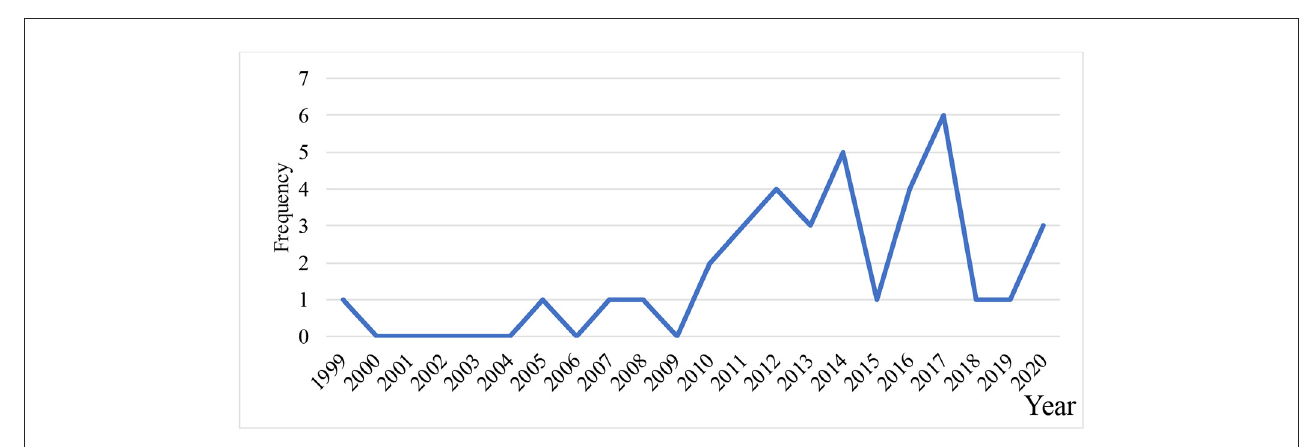
FIGURE2 Distribution of hospital efficiency studies by publication